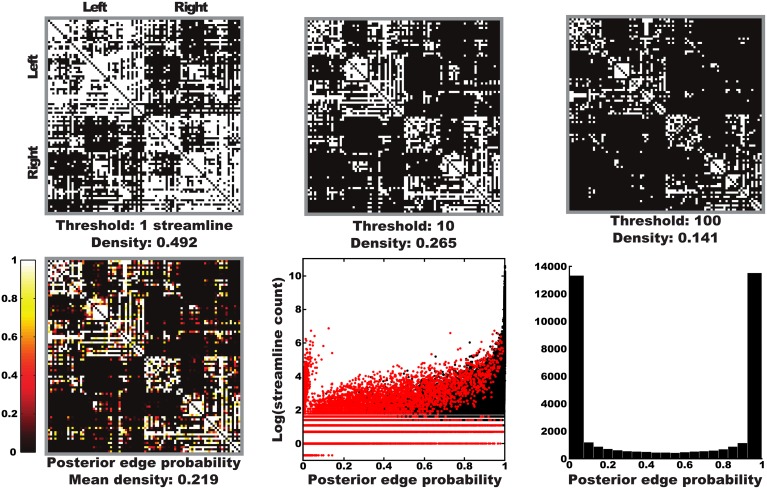
Thresholded graphs and posterior edge probabilities. Top row: illustration of the arbitrariness of thresholded graphs represented as adjacency matrices for a number of possible streamline thresholds for one subject (Subject 7). Bottom left: posterior edge probabilities for one subject as obtained with our Bayesian approach. Bottom middle: scatter plot of posterior edge probabilities vs. log streamline counts over all subjects, with edges present in both posterior and point estimates in black and those only in posterior in red (all edges in the point estimate were present in the posterior). Each edge is represented in both directions. The lower most line represents edges with zero streamline counts in one direction, these are the same edges as the “tuft” of high counts with low probabilities. Bottom right: histogram of non-zero edge probabilities over all subjects. The symmetric appearance is due to the mass of low probability edges being concentrated around very low probabilities.